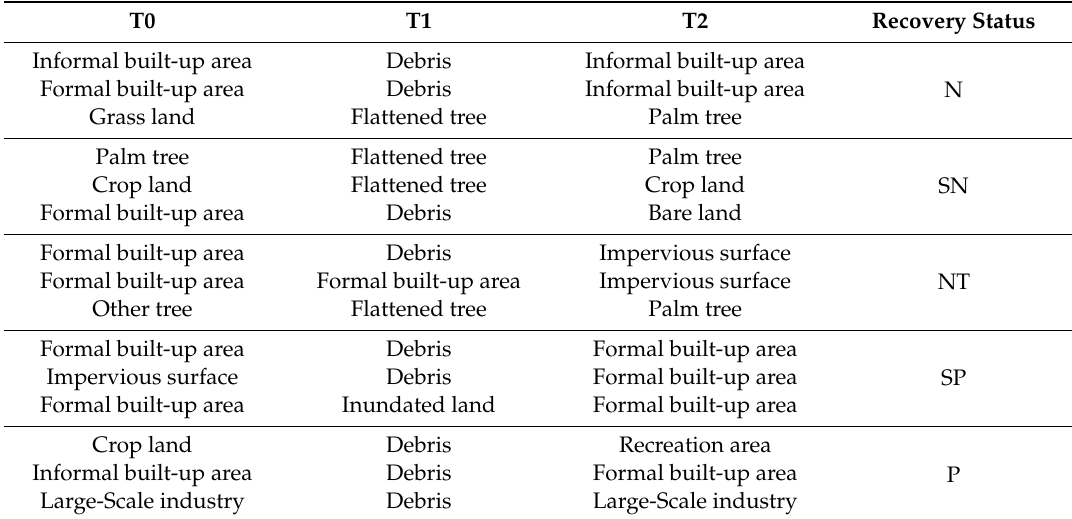
Table 3. LU-based conceptual framework for the post-Haiyan recovery process in Tacloban.